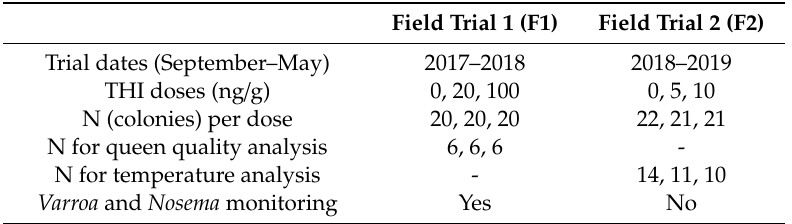
Table 1. Experimental design and sample size (N) of field trials examining survival of outdoor overwintered colonies chronically exposed to thiamethoxam (THI).